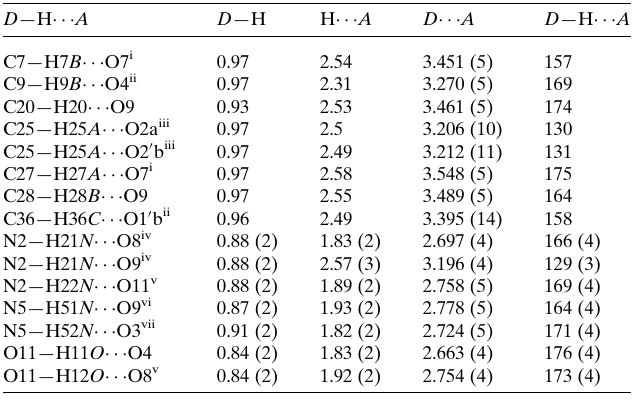
Table 6 Hydrogen-bond geometry (A˚ , (cid:5) ) for (VI).